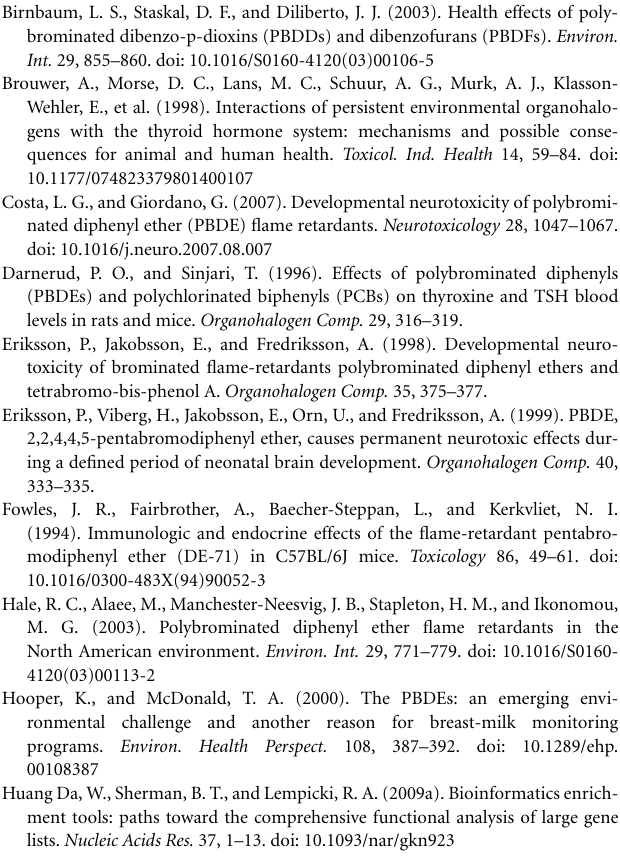
Figure S1 | Frequency of ambiguous nucleotide (N) at each position of read sequences. RNA-seq reads have an extreme low portion of Ns for all three samples. Table S1 | RNA-seq read count of each sample. Table S2 | The differentially expressed genes between each two of the three